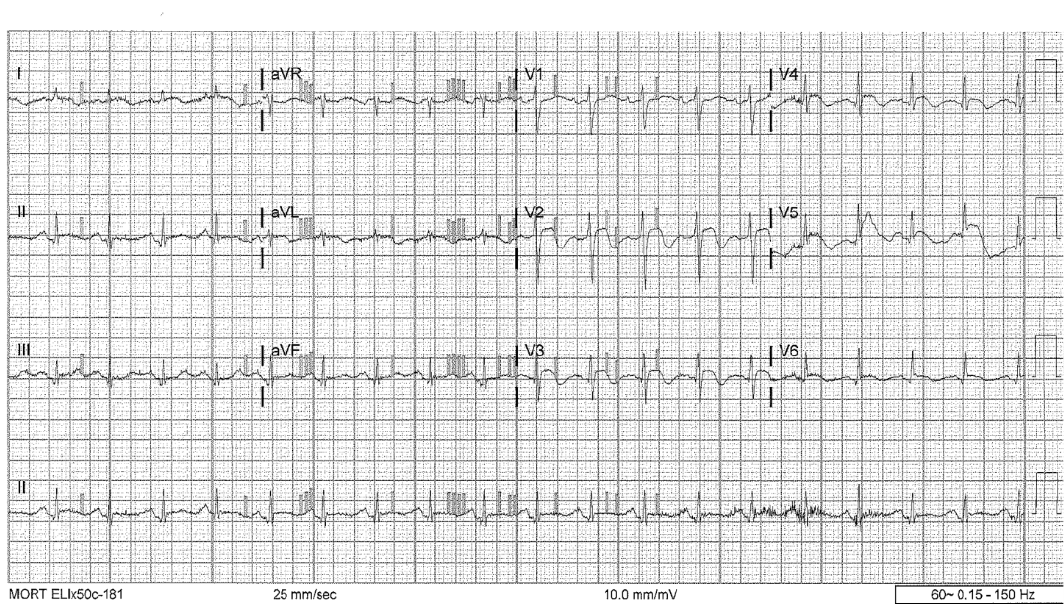
Image. Electrocardiogram depicting Wellens’